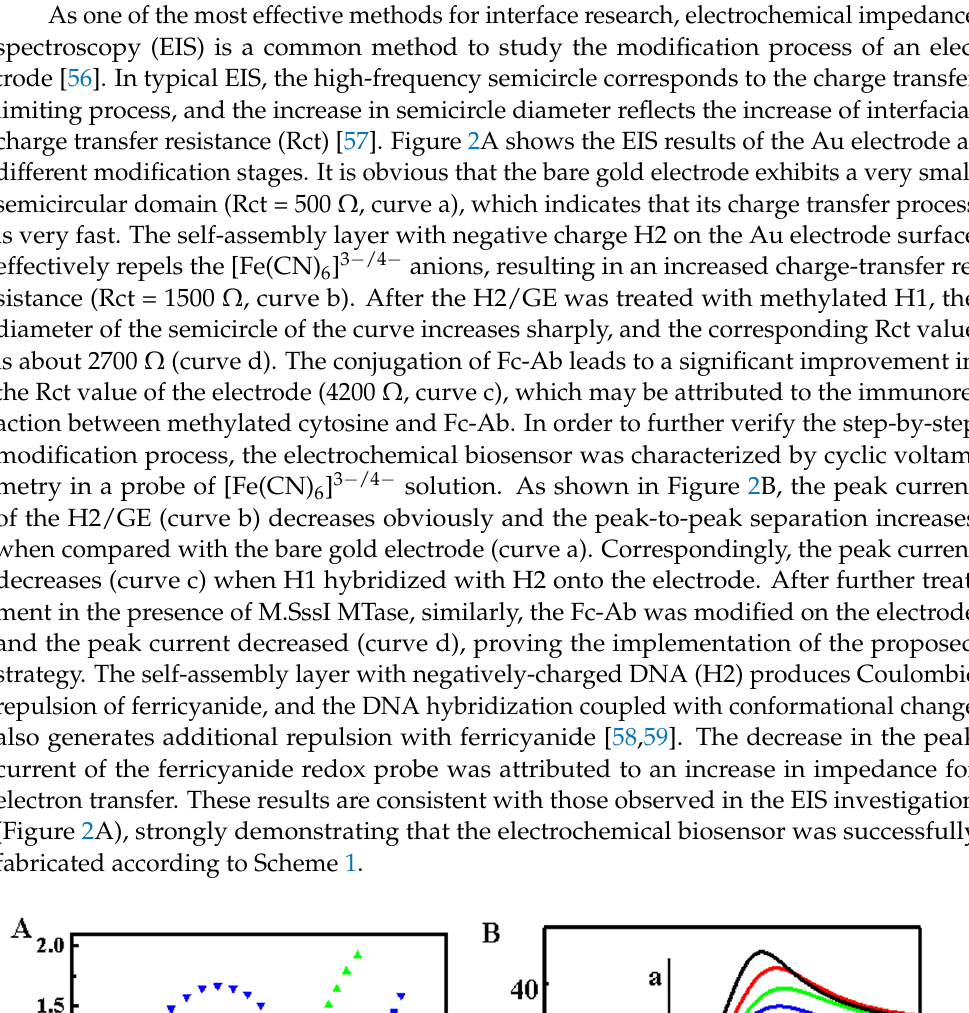
Figure 3. Effects of the temperature ( A ), incubation time ( B ), and pH ( C ) in the presence of 5 μL Fc - Ab. The incubation time of the immunoreactions was another important parameter af- fecting the analytical performance. Hence, the biosensor was prepared with 5 μL Fc -Ab. The value of I Fc was obtained by performing Fc-Ab assembly on the biosensor with differ- ent incubation times. As shown in Figure 3B, the electrochemical response increases quickly with extending the hybridization time from 30 to 120 min. Although a longer in- cubation time makes a slight enhancement in the electrochemical response, considering the detection efficiency, a 2 h optimum incubation time was chosen. pH plays a significant role in DNA hybridization, especially for complementary nu- cleobase interaction and duplex stability; therefore, it is highly advisable to optimize re- action pH to enhance the analytical performance of the biosensor. As shown in Figure 3C, as the reaction pH increased from 6.0 to 7.4, the electrochemical response first increased and then decreased with the further increase of the reaction pH. The maximum value of I Fc of around 4.876 μA occurs at the pH of 7.4 with an assembly time of 2 h at 37 °C. Thus, pH 7.4 was chosen for the subsequent experiments.